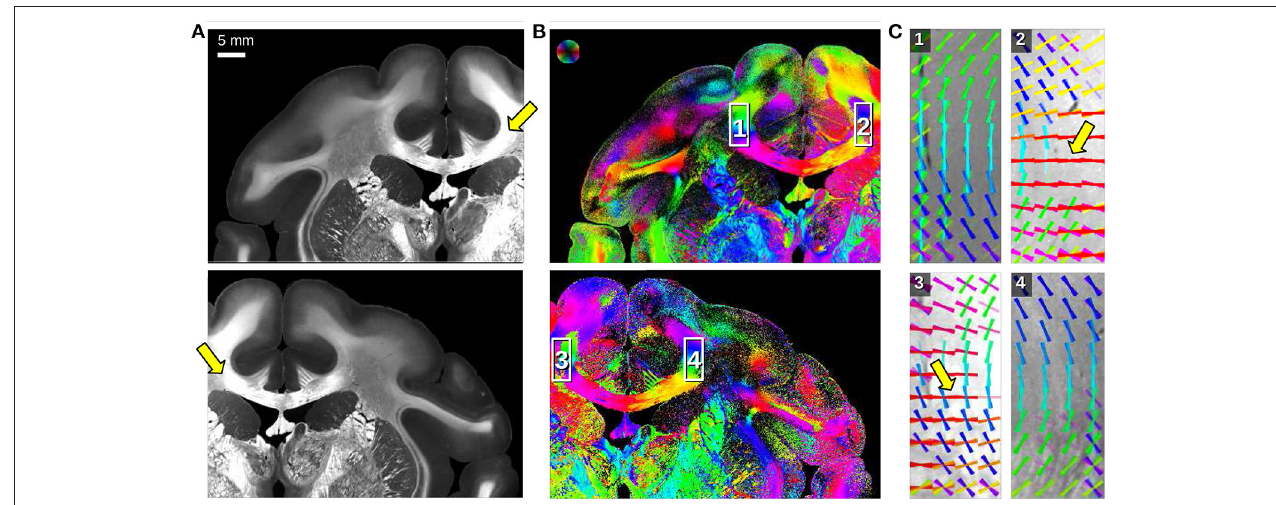
FIGURE 6 | Angular SLI measurements of a coronal vervet monkey brain section (section 512) for different fields of view (left/right hemisphere). The measurements were performed 1 day after tissue embedding with 1φ = 15 ◦ -steps, 0.5 s illumination, and px = 13.7 µ m. (A) Maximum scattered light intensity. (B) In-plane fiber orientations are displayed for each image pixel in different colors. (C) Fiber orientation distribution maps of the regions highlighted in (B) : fiber orientations are displayed on top of each other as colored lines for every 30 × 30 image pixels. The arrows mark artifacts caused by asymmetric illumination of the respective regions.